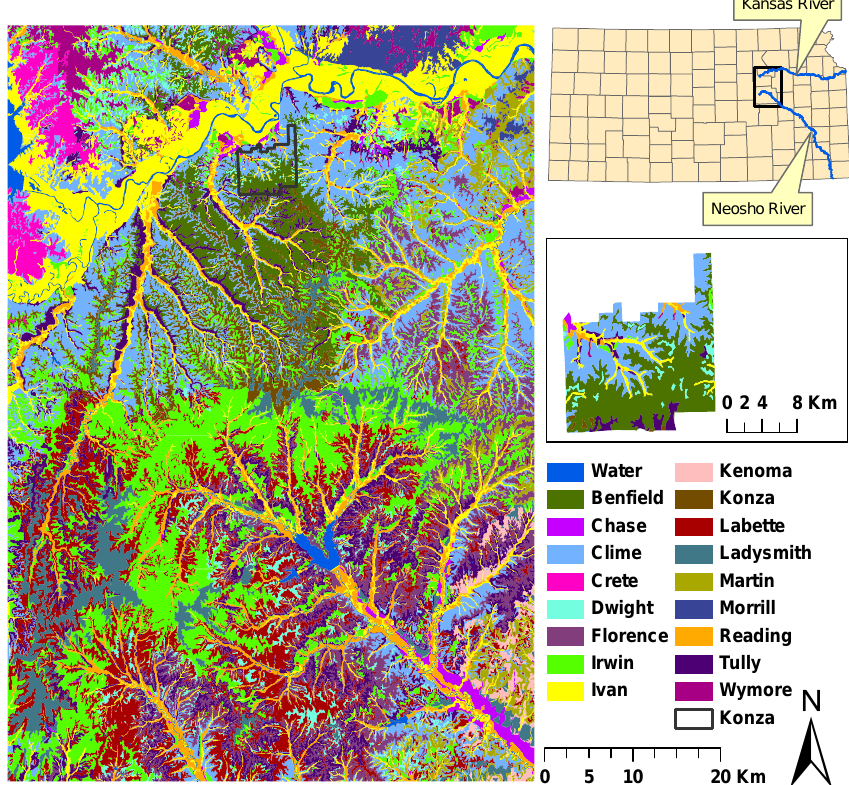
Fig. 2. Soils in the Konza study region.